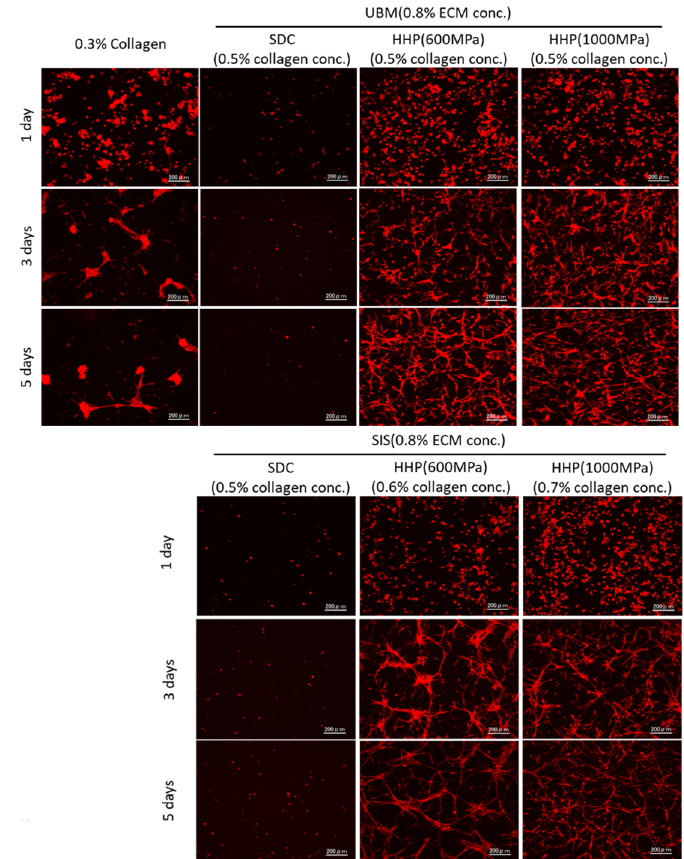
Figure 8. Capillary network structure formed on 0.3% collagen hydrogels and d-ECM hydrogels at 0.8% d-ECM. The calculated collagen concentration in d-ECM hydrogels is shown in brackets. Red represents cytoskeleton stained by Alexa Fluor 546 conjugated phalloidin. Scale bar: 200 µm. SDC and HHP represent the method of decellularization of each tissue (urinary bladder matrix (UBM) and small intestine submucosa (SIS)).